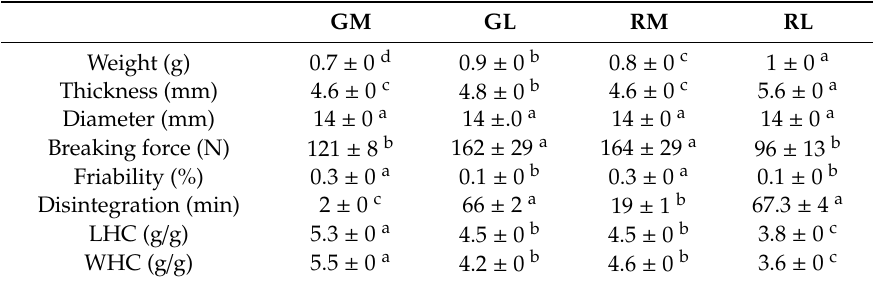
Table 1. Quality and functional parameters of cactus pear residue tablet formulations.